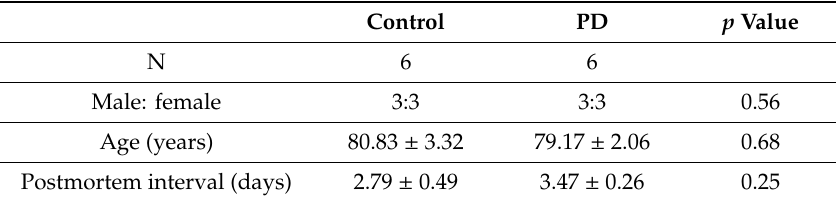
Table 1. Detailed information on postmortem fixed temporal lobe (TL) sections from human PD brains used in this study. Data for age and PMI were expressed as average ± standard deviation. Statistical di ff erences were analyzed by the Chi-squared test for gender ratio, and by the unpaired two-tailed student’s t test for ages and postmortem interval between